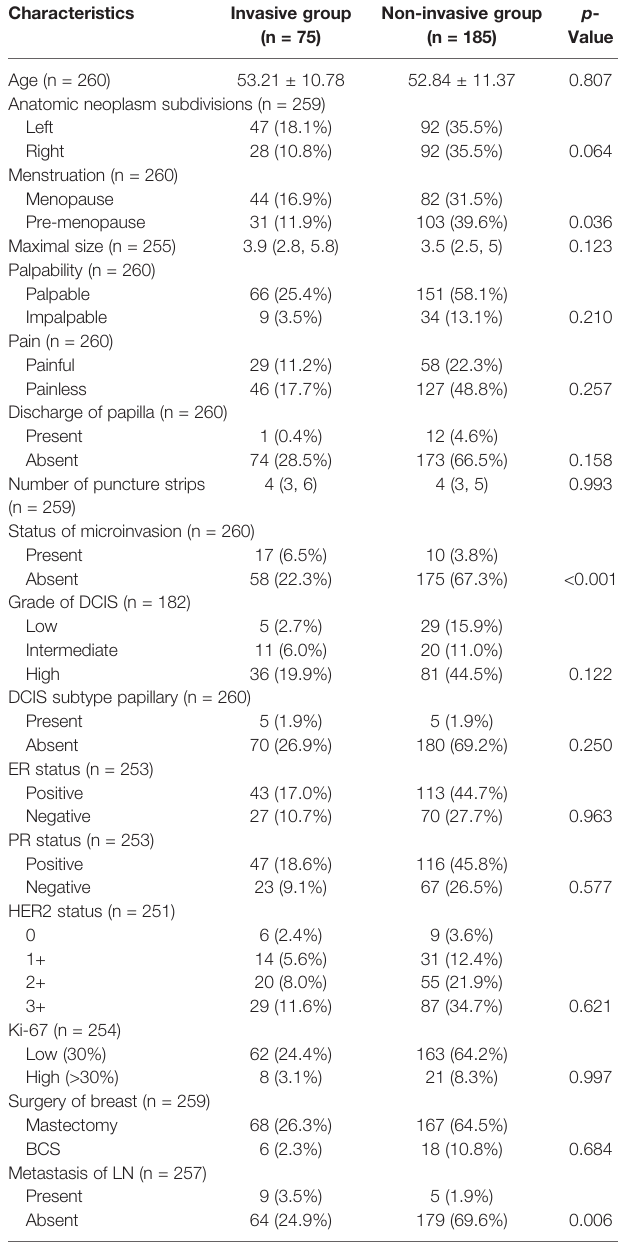
TABLE 1 | Characteristics between invasive and non-invasive